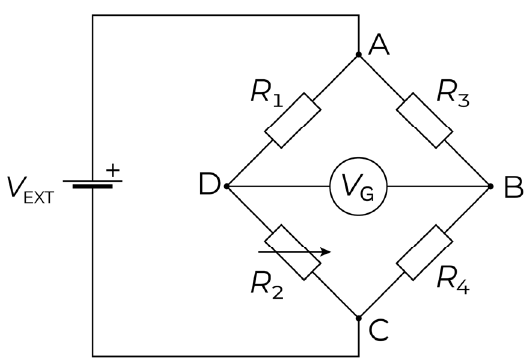
Figure 1. Wheatstone bridge circuit diagram.